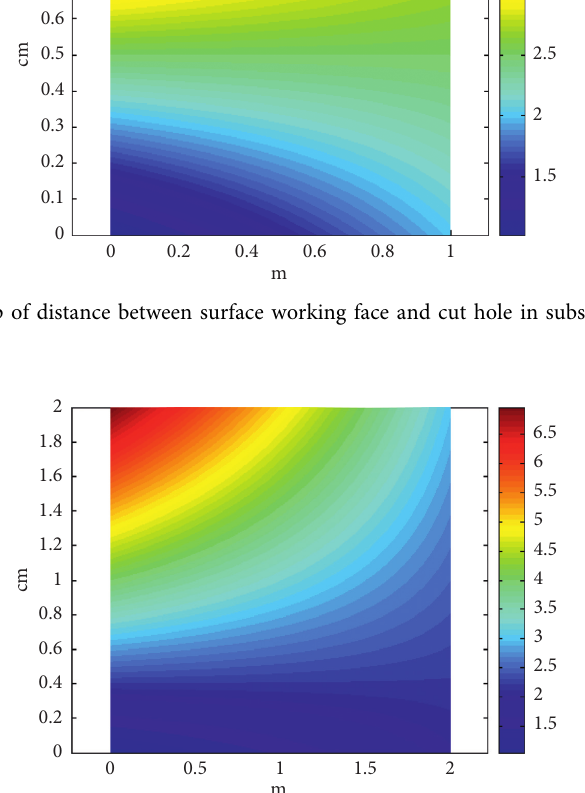
corresponding to the different heights of the corresponding surface fracture zone when the distance between the working face and the cut hole is constant. It can be seen from the figure that when the distance between the surface working